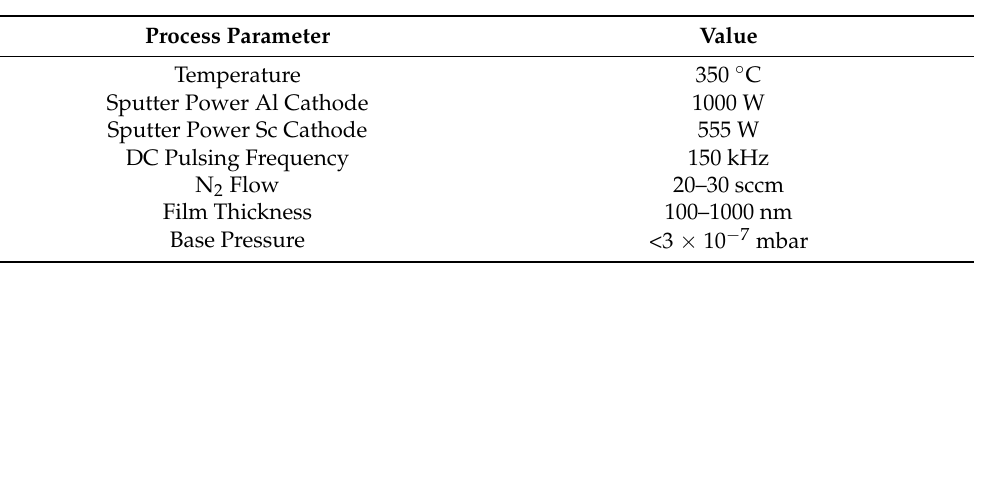
Table 1. Summary of sputter deposition parameters for Al 0.68 Sc 0.32